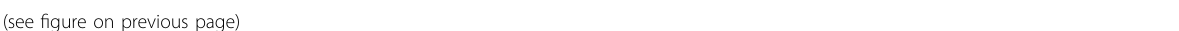
Fig. 5 Attenuated mood-related behaviors by novel p-CRMP2 T514 suppressors. a Paradigm of amphetamine-induced hyperlocomotion (AIH) mouse model. One representative recording is shown. Mouse ambulation pre-amphetamine as well as post-amphetamine exposure was recorded as a control. Effects of treatment with vehicle (blue), Li + (red), compound (green), or compound plus Li + (purple) on mouse ambulation pre- methamphetamine and post-methamphetamine exposure are shown as average (bar graphs, c , e , g ) and time course showing 10-min intervals (line graphs, d , f , h ). Two-way ANOVA ’ s were used to analyze the data from 32 C57BL/6J mice presented in bar graphs with the between-subjects factors Li + (vehicle or Li + ) and compound (vehicle or compound). b Summary of test results for the selected compounds in the AIH assay. A number of functional behavioral response patterns were observed. c , d NNC-711 decreased hyperlocomotion post-AMPH administration to the same degree as lithium and no additive or synergistic effect was detected with Li + , suggesting that it operated in the same pathway and/or employed a shared mechanism hence not augmented by its combination with lithium. e , f Huperzine A also decreased hyperlocomotion post-AMPH administration to the same degree as lithium, and further decrease on combination with lithium. Huperzine A was detected to decrease ambulation prior to amphetamine administration, however, its therapeutic speci fi city for this system is supported by observing that another compound, ropinirole, which also decreased activity pre-amphetamine, did not do so post-amphetamine. g , h Sulpiride decreased post-AMPH hyperlocomotion when combined with Li + but not on its own, suggesting it may work in a parallel pathway. Hence NNC-711 and huperzine A might be viewed as a substitute for lithium while sulpiride might be thought of as an adjunct to